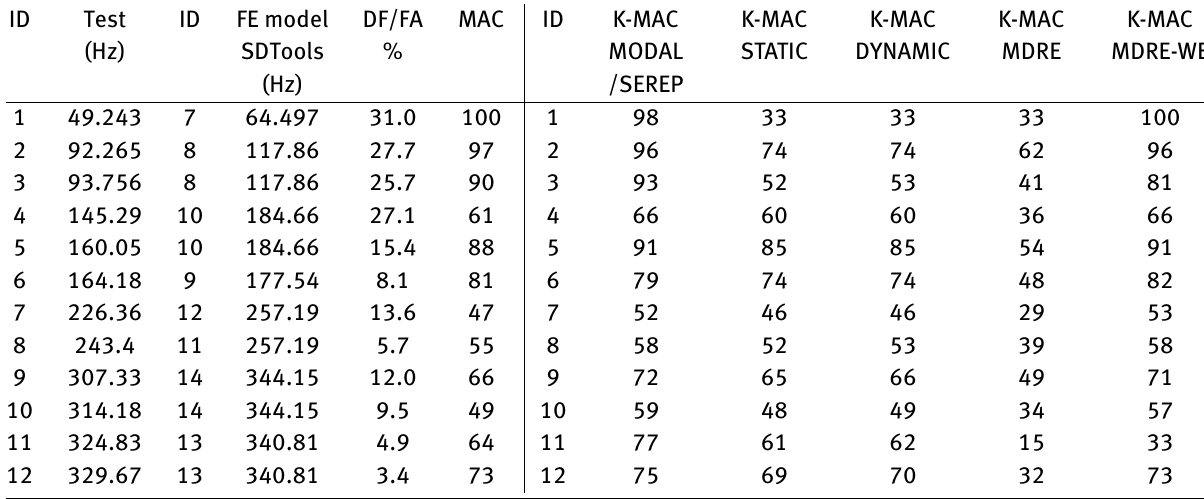
Table 7: Comparative MAC: Contrieved full model (SDTools) and K-MAC MSE results vs. experimental measurements. ID